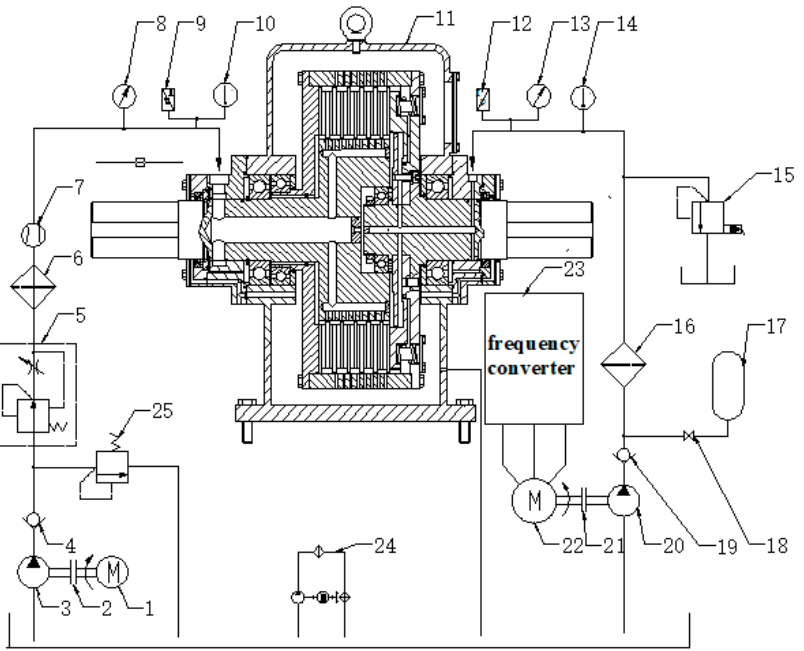
Figure 12. Diagram of the hydraulic system for HVC. 1,22—oil pump motor; 2,21—coupling; 3—